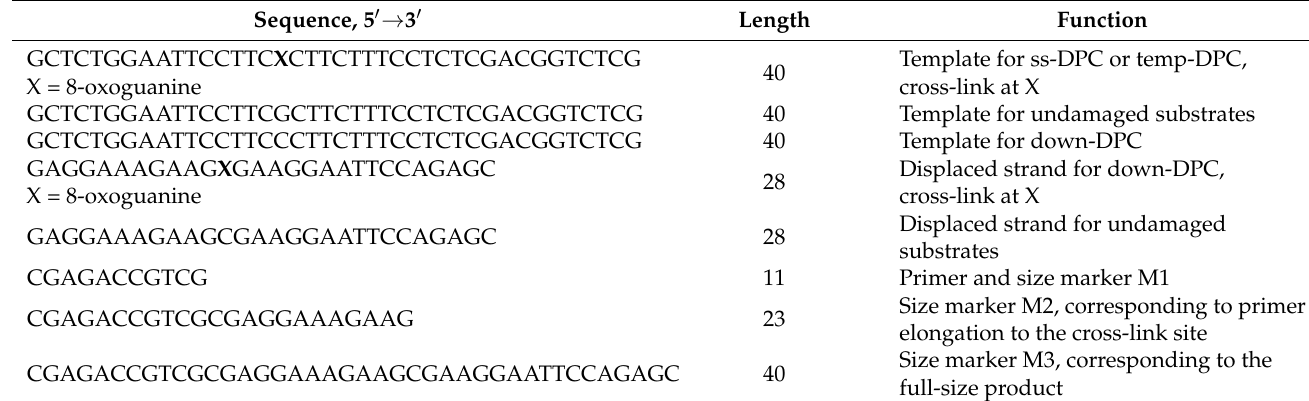
Table 1. Oligonucleotides used in this study.